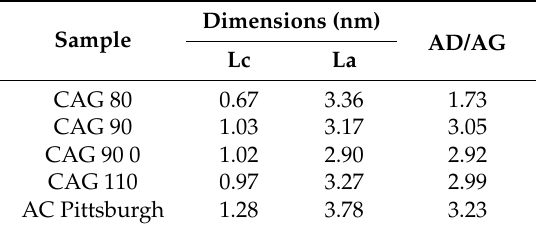
Table 6. Graphite crystallite dimensions (from X-ray diffraction (XRD) analysis) and bands D and G areas ratio (from Raman spectroscopy